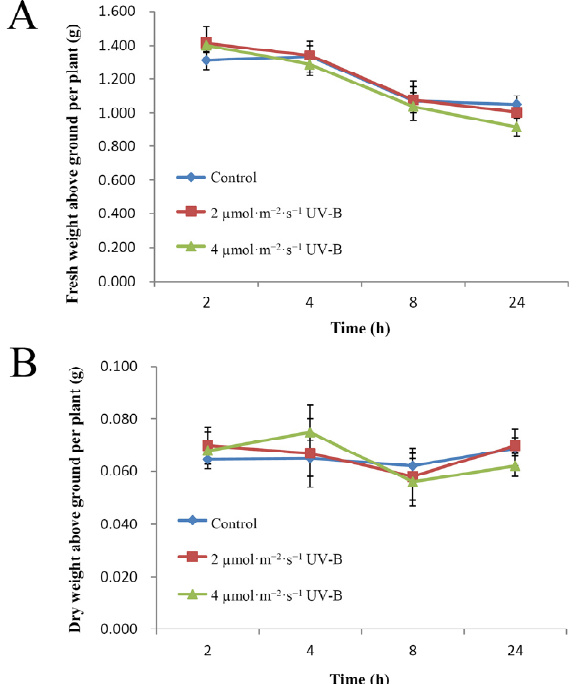
Figure 1. The effect of ultraviolet-B (UV-B) radiation on the above-ground biomass of pakchoi. ( A ) Fresh weight of 25-day-old seedlings treated with either 2 µmol·m − 2 ·s − 1 or 4 µmol·m − 2 ·s − 1 of UV-B irradiation for 2 h, 4 h, 8 h, or 24 h. ( B ) Dry weight of 25-day-old seedlings treated with either 2 µmol·m − 2 ·s − 1 or 4 µmol·m − 2 ·s − 1 of UV-B irradiation for 2 h, 4 h, 8 h, or 24 h. The plants without supplemental UV-B radiation served as controls. Data points are mean ± SE of three biological replicates. Significant differences between treated group and the control group at the same exposure period, identified by Student’s t -test analysis.